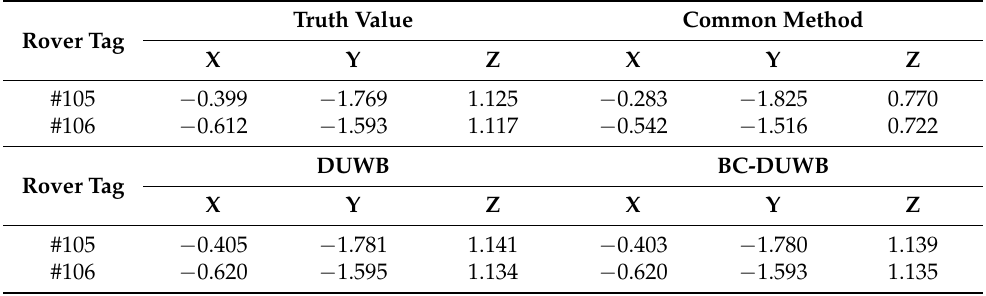
Table 7. STD and RMSE of Test 2 with Different Methods (cm).